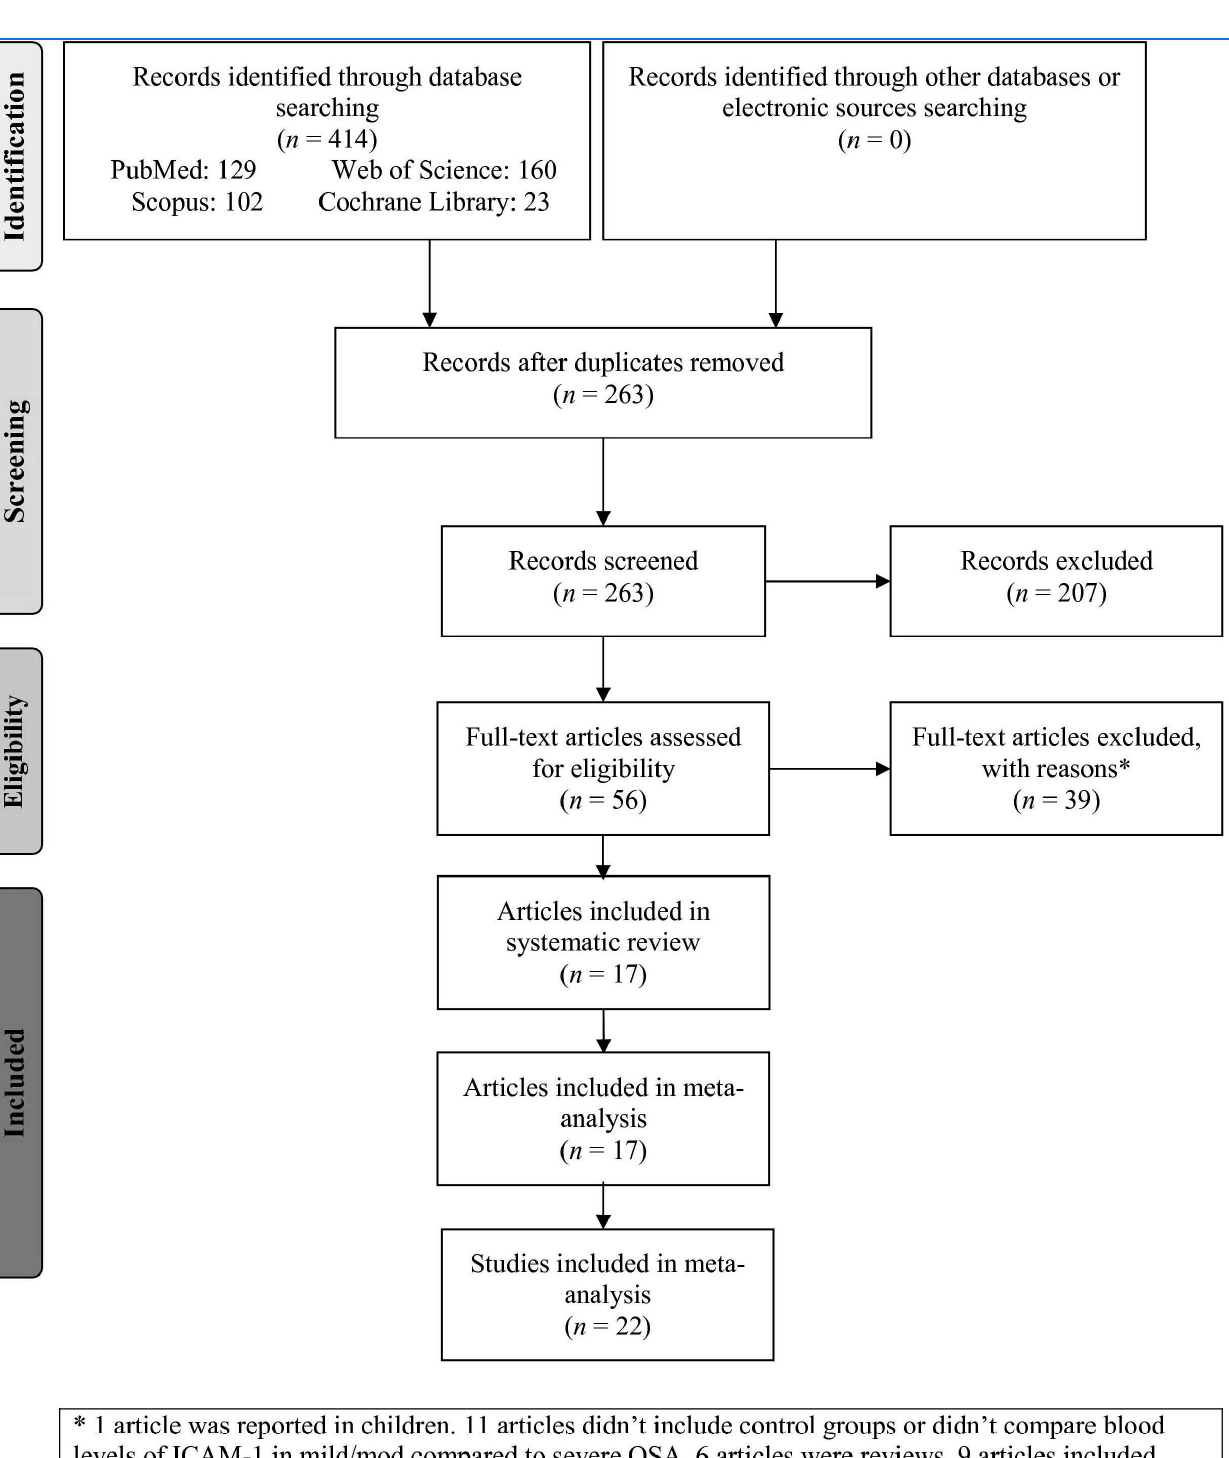
Figure 1. Flowchart of the study selection. ICAM-1: Intercellular adhesion molecule-1. AHI: Apnea-hypopnea index. OSA: Obstructive Sleep Apnea.